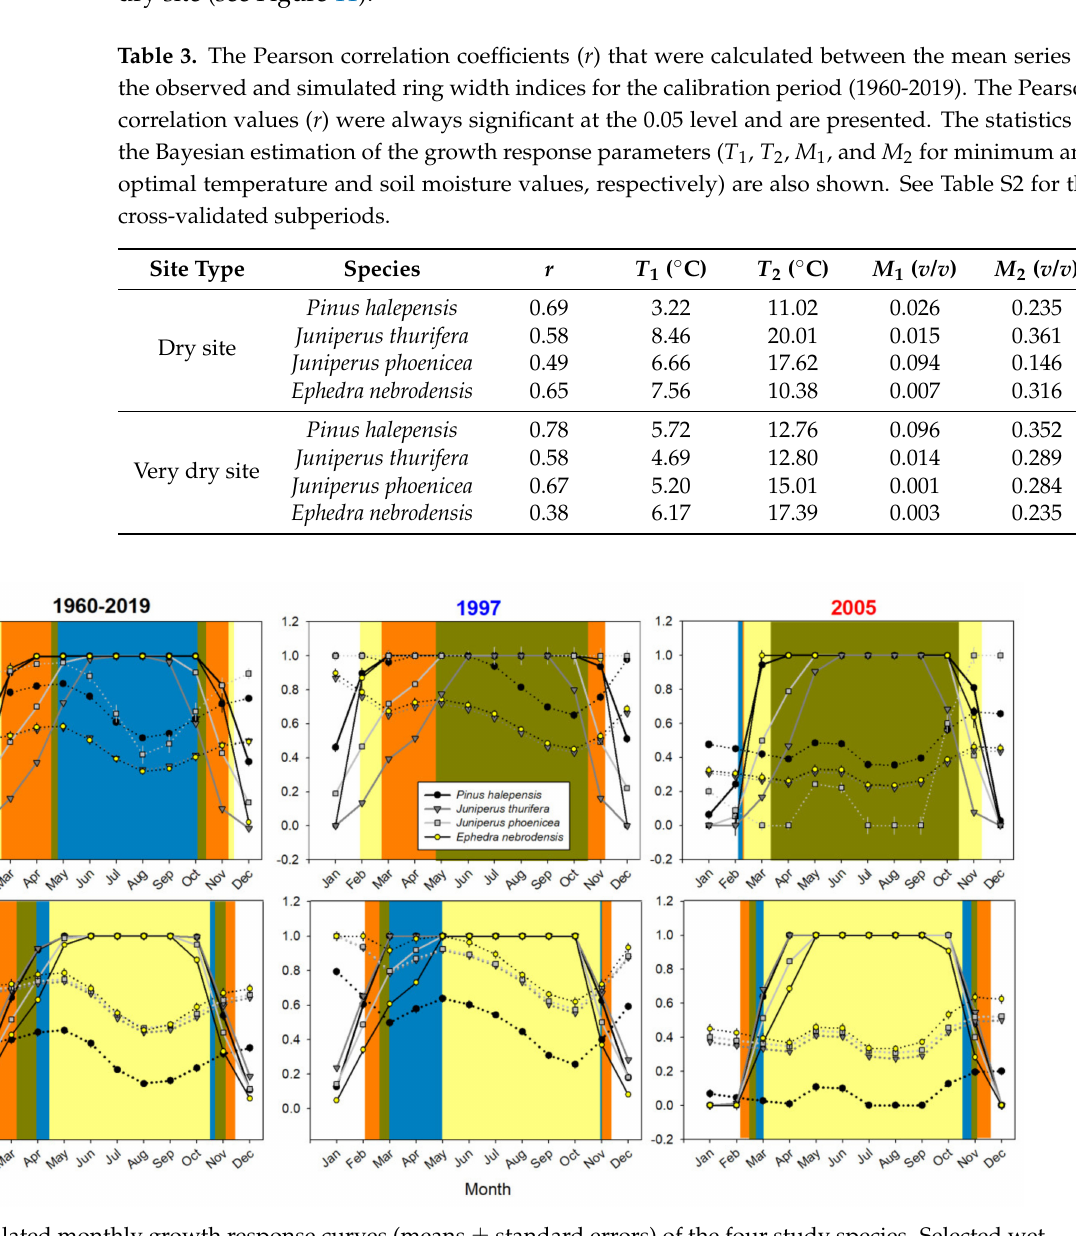
Figure 11. Simulated monthly growth response curves (means ± standard errors) of the four study species. Selected wet (1997) and dry (2005) years (see Figures 1 and 3) are also shown. The growth responses consider the temperature (gT, solid lines) and soil moisture parameters (gM, dotted lines). The orange, green, blue, and yellow areas, encompassing late prior winter to late current autumn months, indicate periods that had soil moisture limitations for P. halepensis , J. thurifera , J. phoenicea , and E. nebrodensis ,